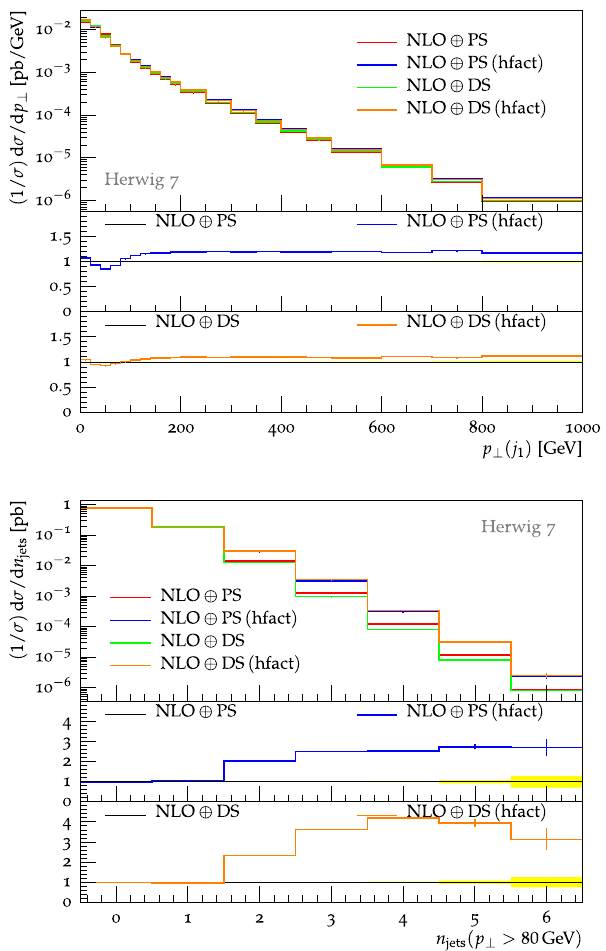
Fig. 12 The effect of different profile scale choices for the two shower algorithms, angular ordered (PS) and dipole (DS), respectively when using MC@NLO-type (NLO ⊕ ) matching. We compare predictions for the default resummation profile versus the broader hfact profile. From